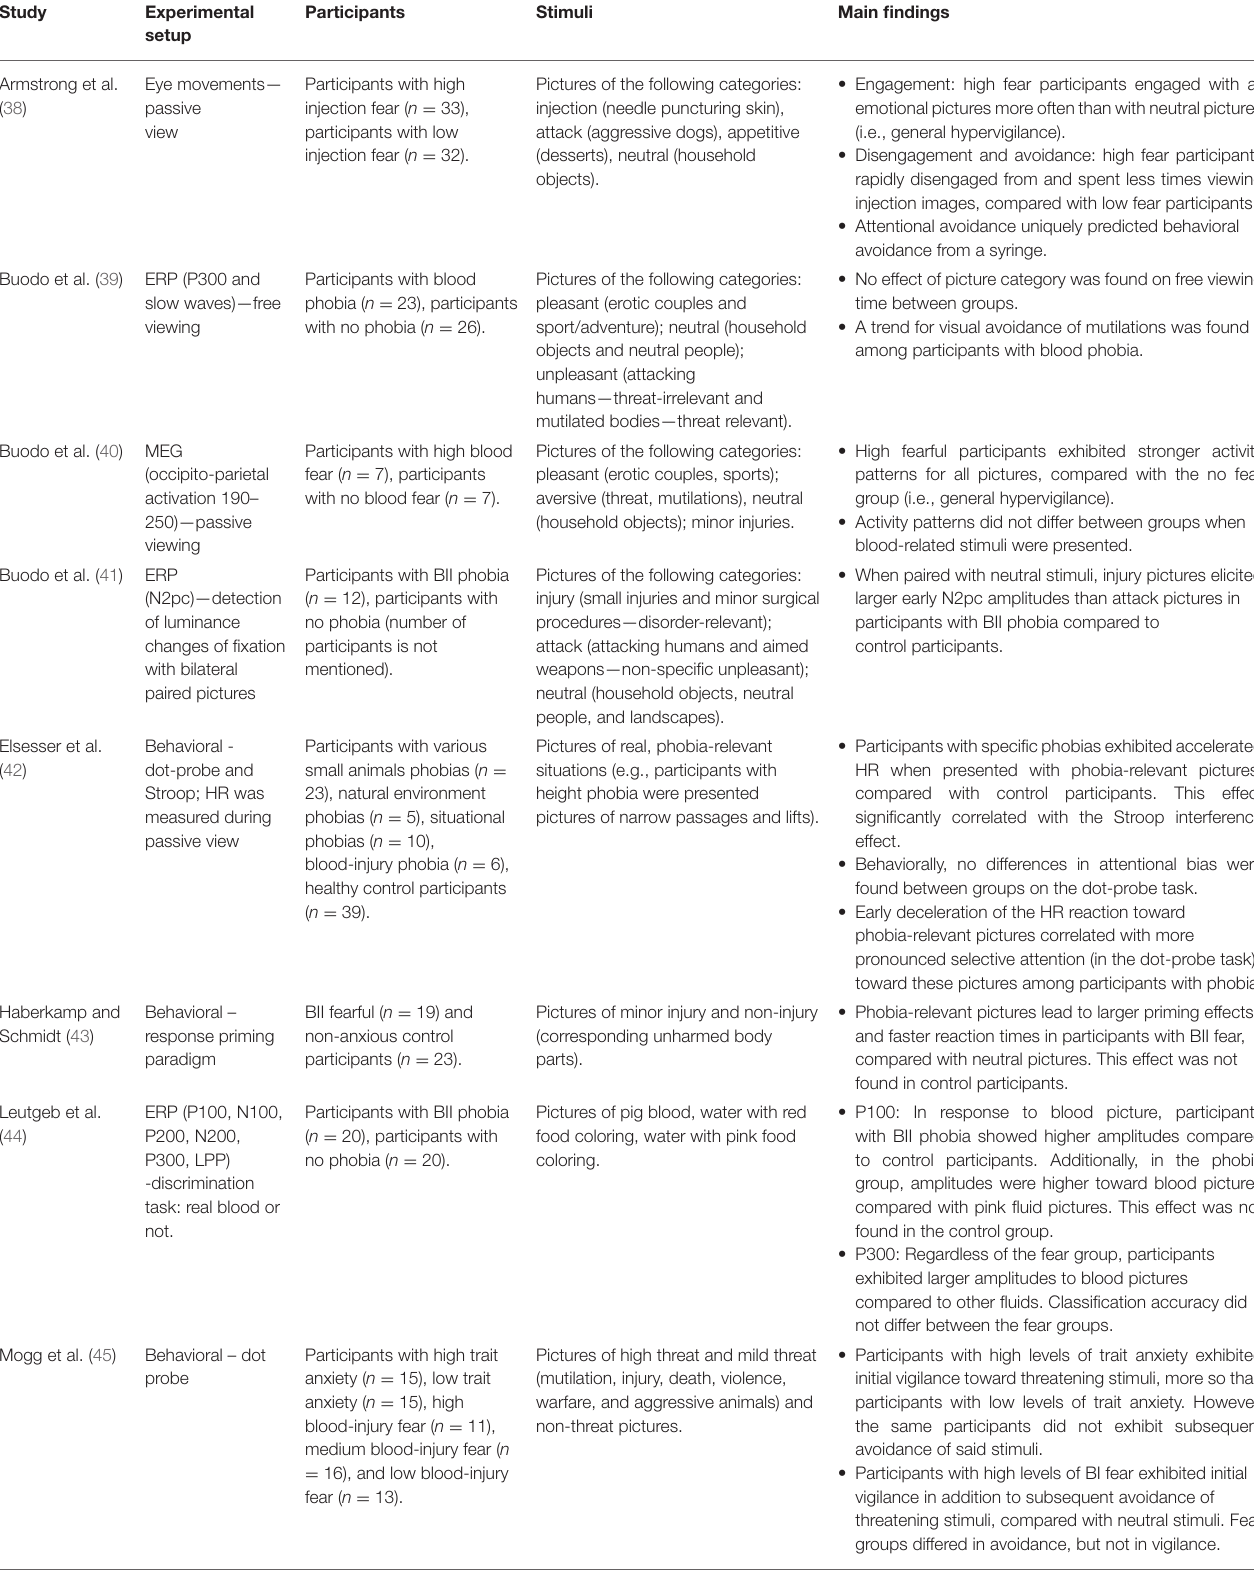
TABLE 1 | Summary of studies on attention bias in BII phobia.